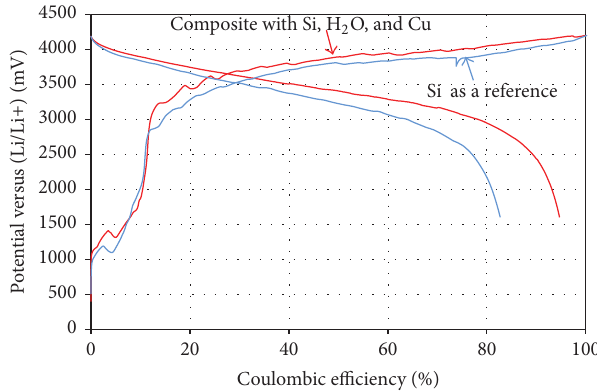
Figure 10: First coulombic efficiencies of the composite anode (red) and a Si particle reference (blue).